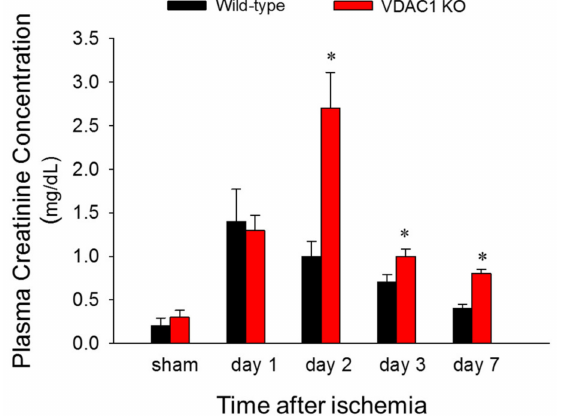
Figure 2. Deletion of VDAC1 delays recovery of renal function after ischemia. Renal function was evaluated using creatinine levels in mouse plasma collected from sham mice and at di ff erent time points during recovery after bilateral renal ischemia (35 min) in WT and VDAC1 KO mice. Results are the average ± S.E. of data obtained from 3–13 animals. * Values significantly di ff erent ( p < 0.05) from respective sham